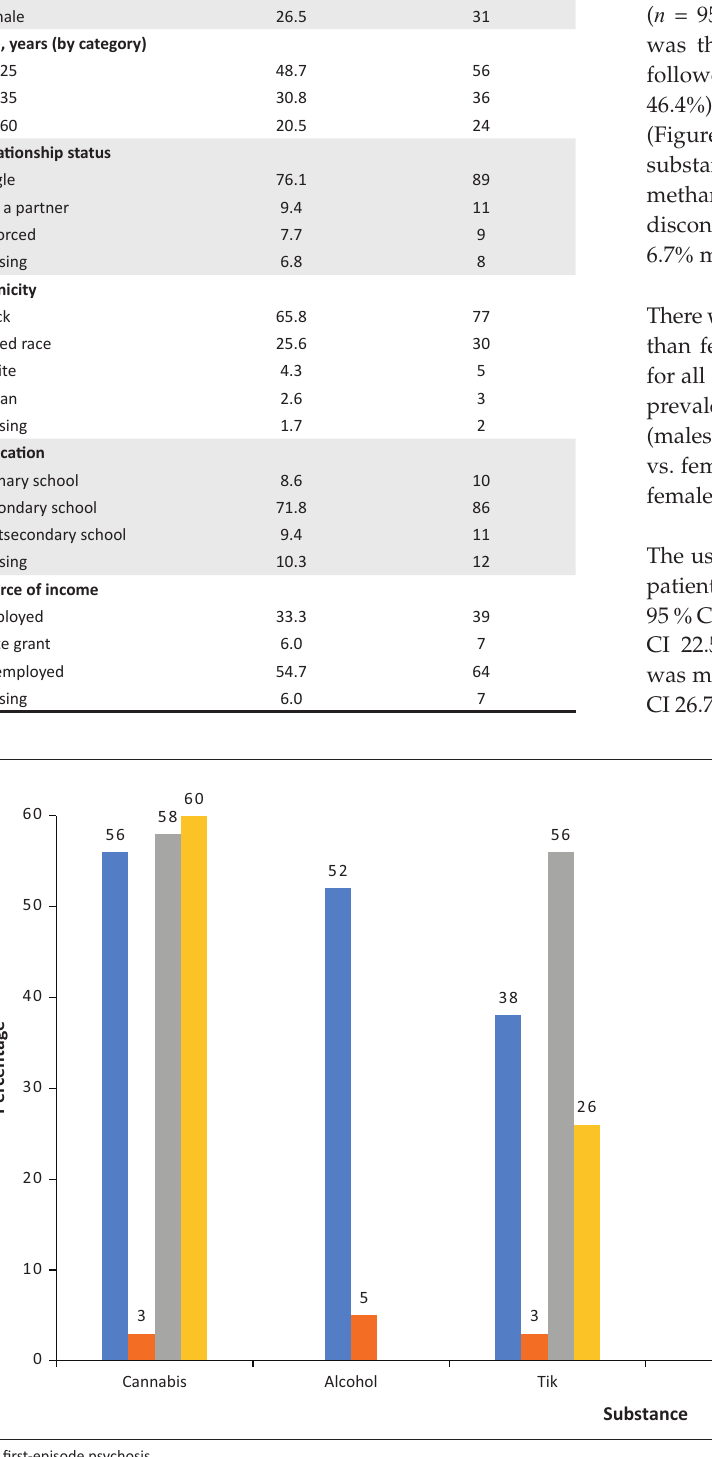
FIGURE 1: Bar chart showing current and past substance use history, percentage of those tested for substances and positive test results on those who had urine drug